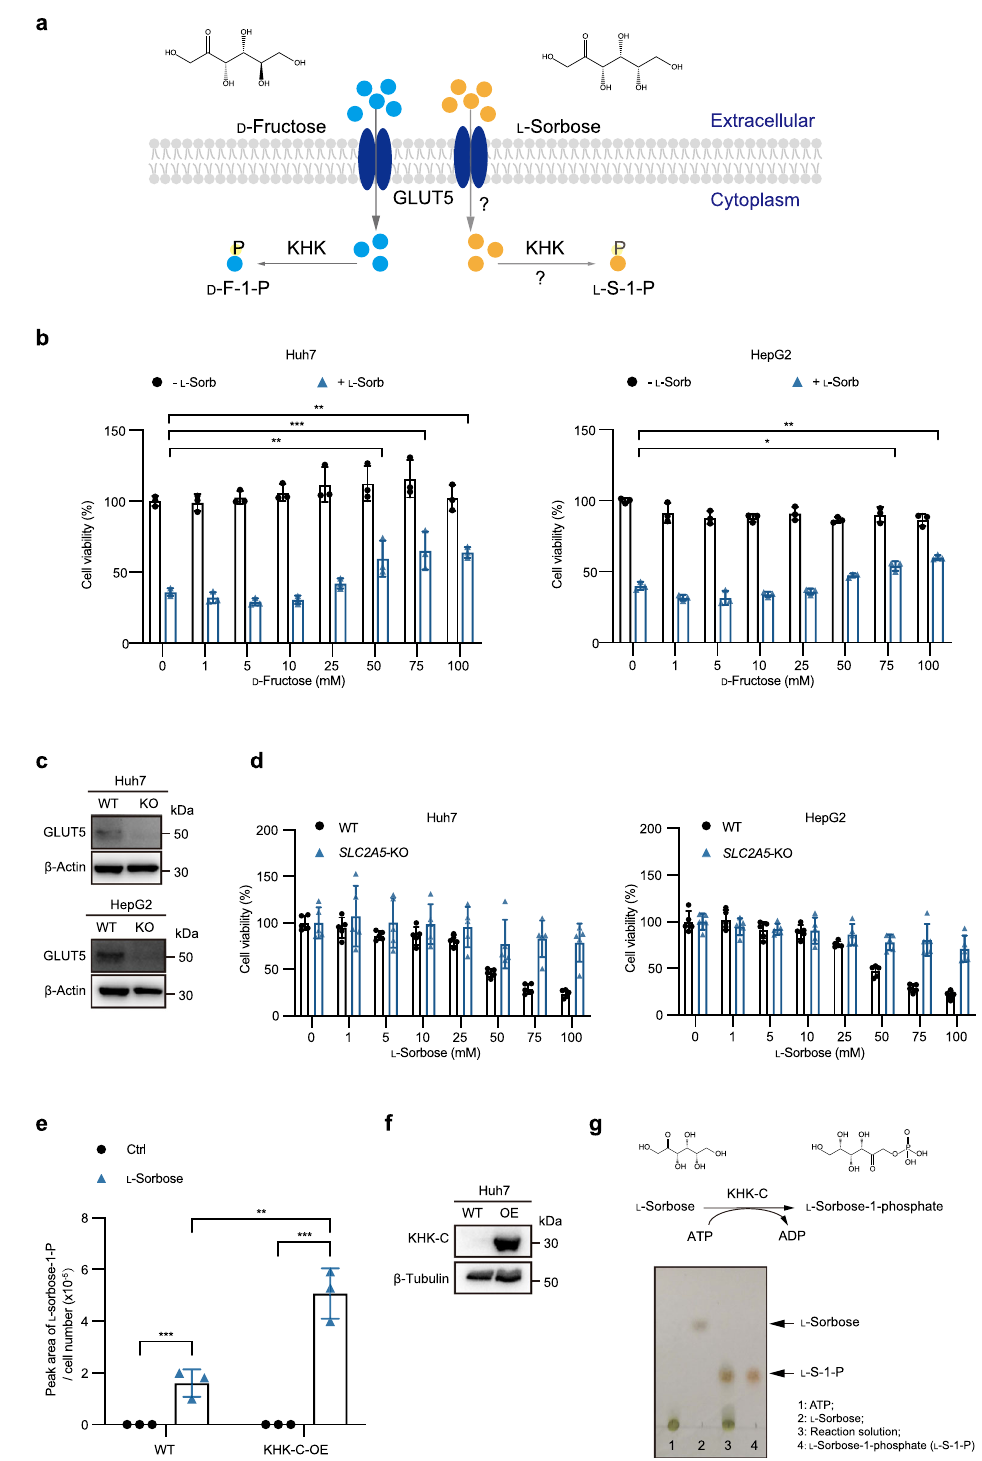
Fig. 5 L -Sorbose internalizes cells through GLUT5 and accumulates as L -sorbose-1-phosphate. a , Schematic diagram of fi rst two steps of fructose metabolism and the hypothesis for L -sorbose. b , Viabilities of Huh7 and HepG2 cells treated with or without L -sorbose (25 mM) and the indicated concentrations of D -fructose for 24 h. n = 3. c , Western blot to detect GLUT5 in wild-type and SLC2A5 -KO cells. d , Cell viabilities of wild-type or SLC2A5 - KO cells treated with the indicated concentrations of L -sorbose for 24 h. n = 5. e , Huh7 cells with or without overexpression of KHK-C were cultured in the presence or absence (ctrl) of L -sorbose for 24 h. The intracellular amount of L -sorbose-1-phosphate ( L -S-1-P) was detected by LC-MS. n = 3. f , Western blot veri fi ed the overexpression of KHK-C in Huh7 cells. g , Recombinant KHK-C was incubated with 200 μ L 50 mM Tris – HCl buffer (pH 7.5) containing 5 g/L L -sorbose, 3 mM MnCl 2 , 3 mM MgCl 2 and 25 mM ATP. Top panels: The KHK-C reaction equation. Bottom panels: TLC analysis was performed to measure the production of L -S-1-P. Data are presented as the mean ± s.d. and were analyzed by unpaired two-tailed Student ’ s t test. * P < 0.05, ** P < 0.01, *** P <